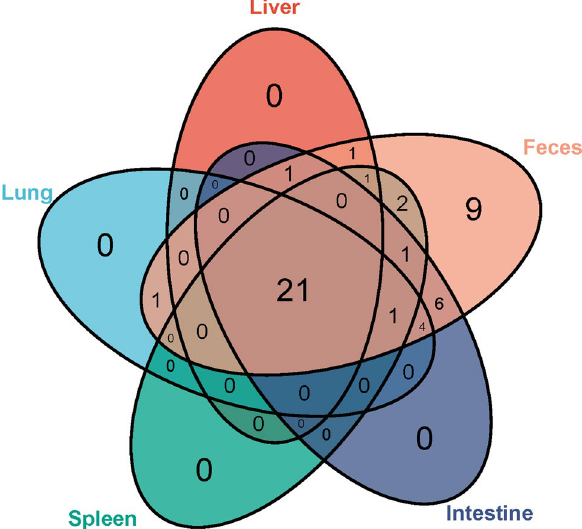
Figure 3. Venn diagram of viral families shared in the five tissues. The numbers represent viral families found in each tissue. A total of 48 viral taxa were analyzed and displayed, which included 46 viral families, one unclassified virus and one unclassified